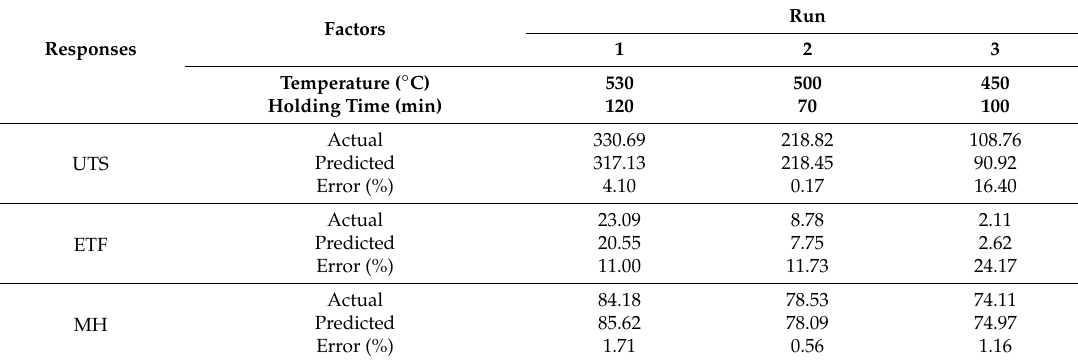
Table 7. Confirmation